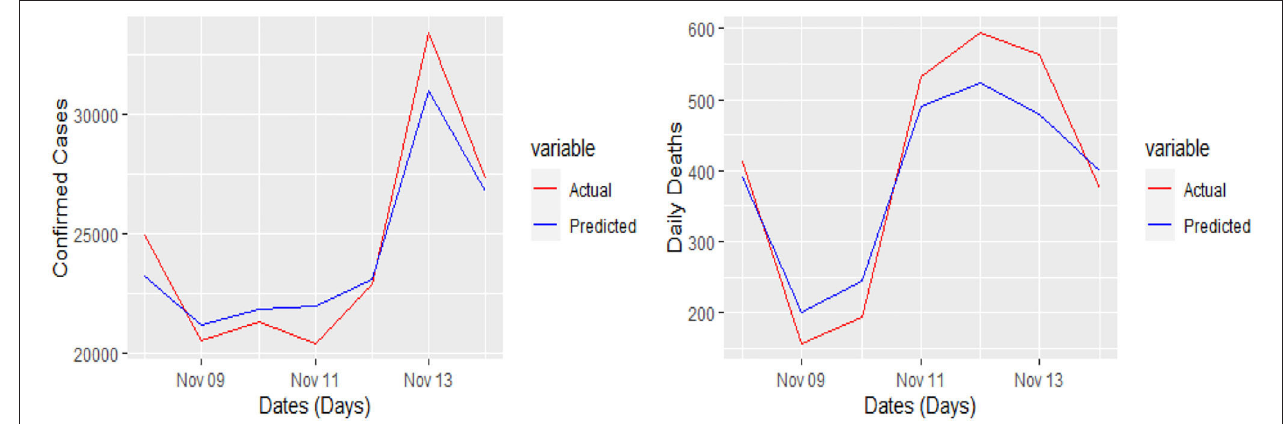
FIGURE 8 | Actual and predicted 7 days daily confirmed cases and daily deaths from COVID-19 in the